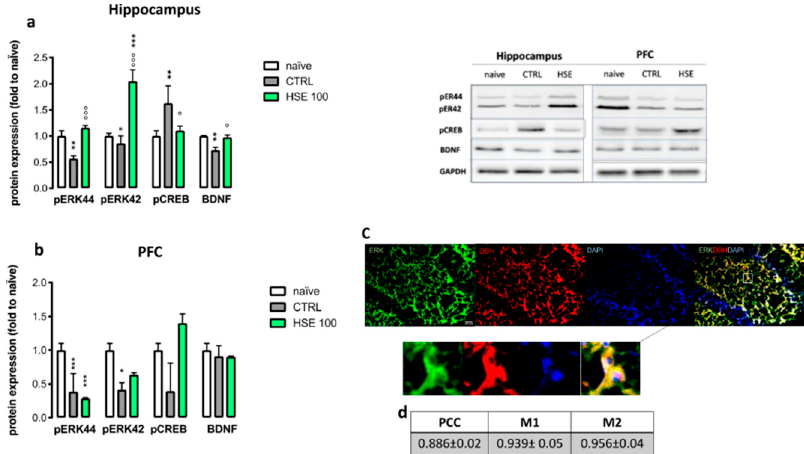
Figure 5. ( a ) Helichrysum stoechas Moench methanolic extract (HSE) increased the phosphorylation